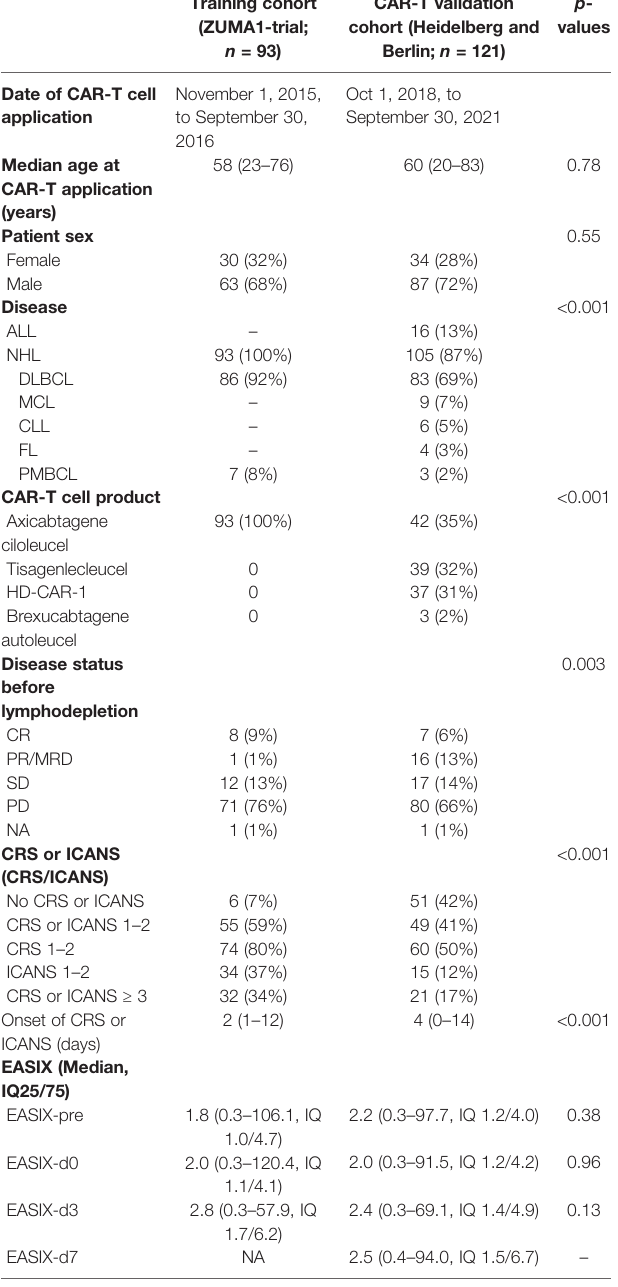
EASIX,EndothelialActivationandStressInde;CAR,chimericantigenreceptor;ALL,acute lymphoblastic leukemia; NHL, non-Hodgkin lymphoma; DLBCL, diffuse large B-cell lymphoma; MCL, mantle cell lymphoma; CLL, chronic lymphocytic leukemia; FL, follicular lymphoma; PMBCL, primary mediastinal B-cell lymphoma; HD-CAR-1, Heidelberg Chimeric Antigen Receptor Trial 1; CR, complete remission; PR, partial remission; SD, stable disease; PD, progressive disease; CRS, cytokine release syndrome; ICANS, immune effector cell-associated neurotoxicity syndrome; IQ = interquartile [25/75, Q1/Q3 (lower and upper quartile)]; NA, not available. EASIX-pre trainingn=90,validation n=121;EASIX-d0trainingn=85, validationn=121; EASIX-d3 training n = 85, validation n = 121; EASIX-d7 training not applicable, validation n =